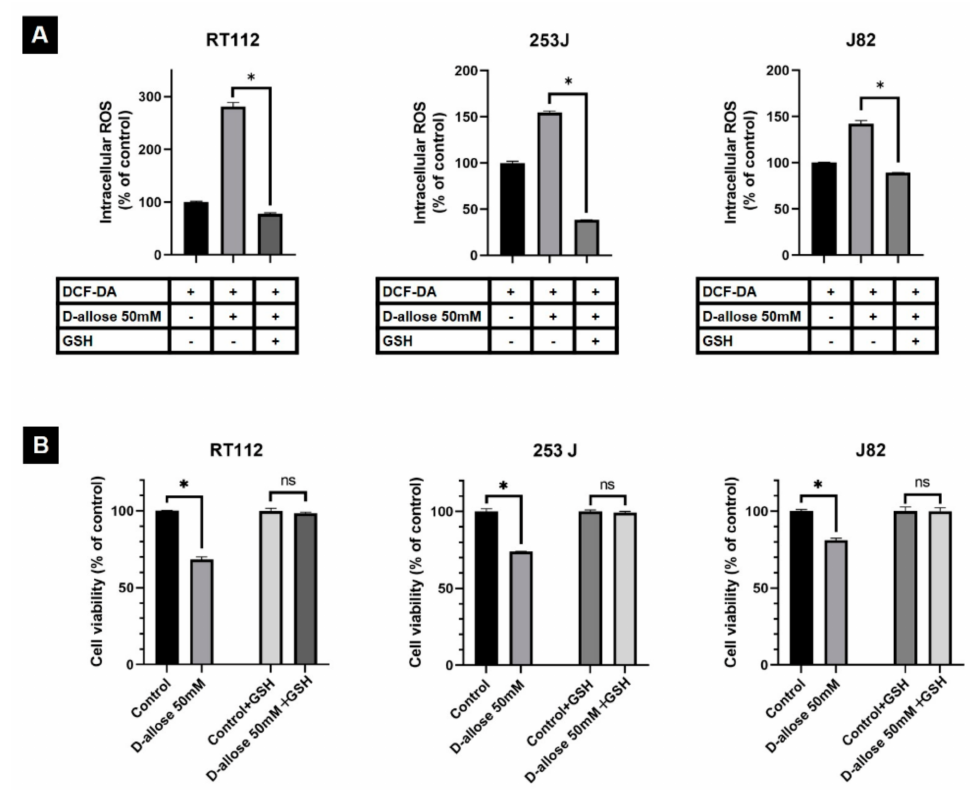
Figure 3. Co-treatment of D-allose and antioxidant glutathione (GSH) suppressed the D-allose- induced intracellular reactive oxygen species (ROS) elevation and cell viability inhibition in three bladder cancer cell lines. ( A ) A fluorescence-activated cell sorting (FACS) analysis showed a signifi- cant decrease in intracellular ROS at 1 h post-treatment of 50 mM D-allose with GSH in RT112, 253J, and J82, respectively, compared with the control (2 (cid:48) ,7 (cid:48) -dichlorofluorescindiacetate [DCF-DA]; A ). Statistically significant ( p < 0.05) increases in intracellular ROS rates compared with the control (set at 100%) are represented by asterisks (*). ( B ) The MTT assay revealed that the antioxidant GSH reduced the inhibition of RT112, 253J, and J82 bladder cancer cell viability by D-allose. Statistically significant ( p < 0.05) decreases in cell viability rates compared with the control (set at 100%) are represented by asterisks (*). ns: not